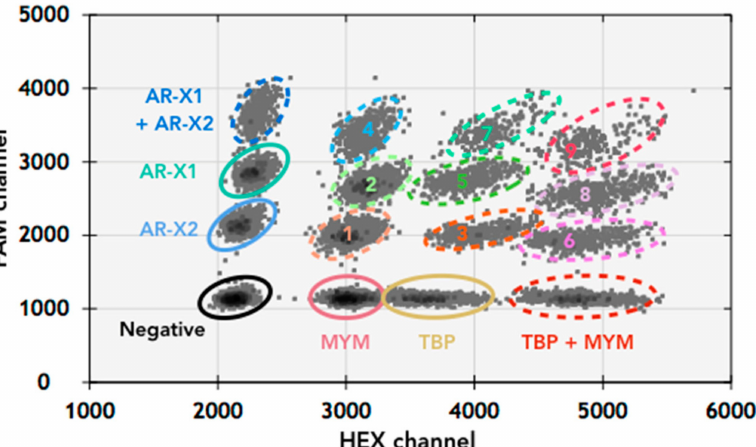
Figure 2. Two-dimensional plot of multiplexed AR-Amp-2 ddPCR assay. The individual droplet clusters demonstrated good separation of different amplicons as shown in the representative 2D